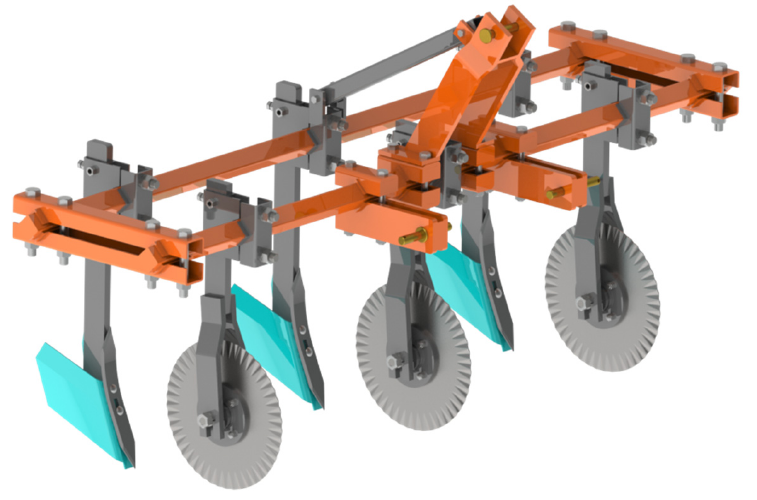
Figure 2. Implement with cutter discs and furrowers, employed to reform the furrows between permanent beds.